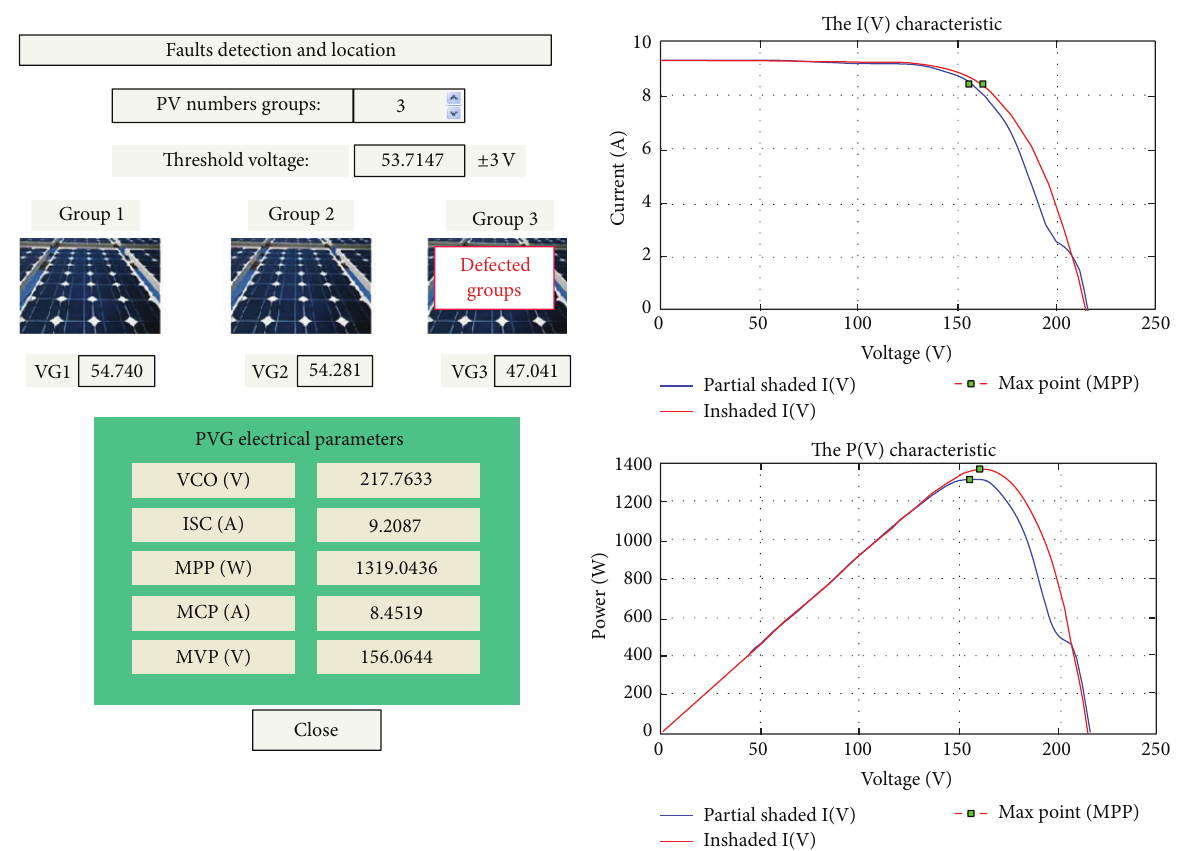
Figure 9: Screenshot of the GUI in case of partial shading in